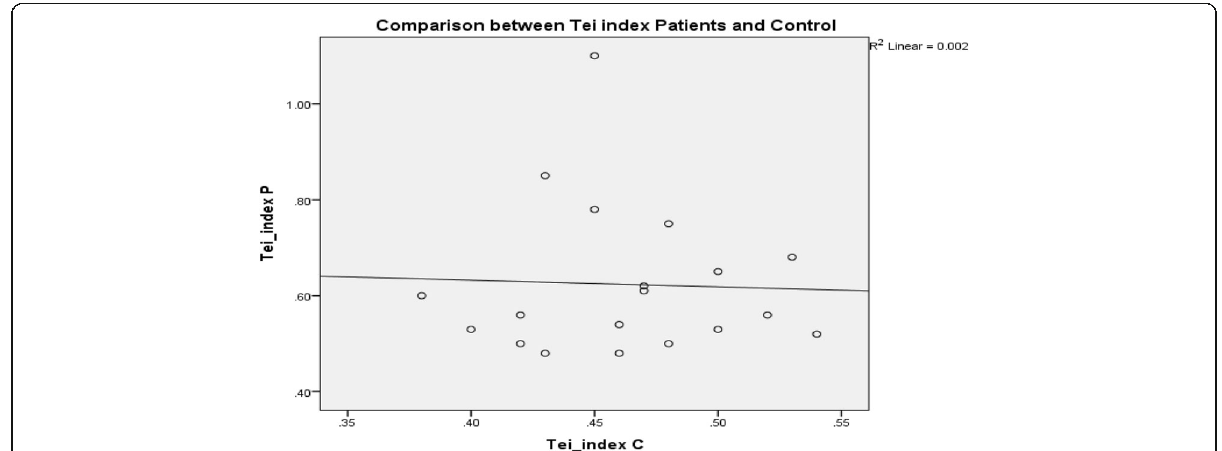
Fig. 4 Linear regression curve to illustrate significant correlation between Tie Index for both patients and controls (correlation coefficient R 2 =